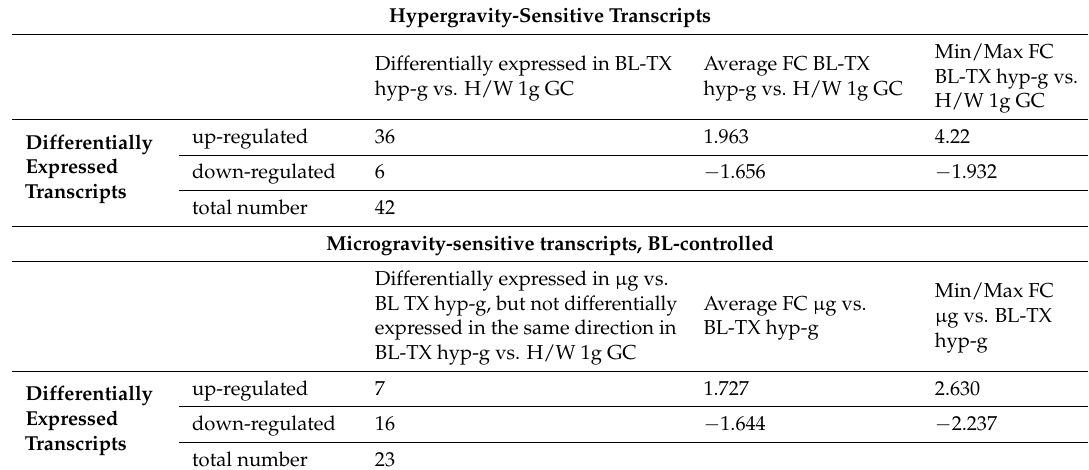
Table 5. Numbers of transcripts that are differentially expressed in response to altered gravitational conditions in the TEXUS-49 suborbital ballistic rocket campaign. Transcripts that were significantly changed in the control comparisons were eliminated. Differential expression is defined as t -test p -value < 0.05; fold change (FC) ≤ − 1.3 or ≥ +1.3. FCs are ratios between the averages of linear expression values. If the ratio is <1, FC is calculated as the negative reciprocal of the ratio. For the abbreviations of the experiment group names see Table 1.